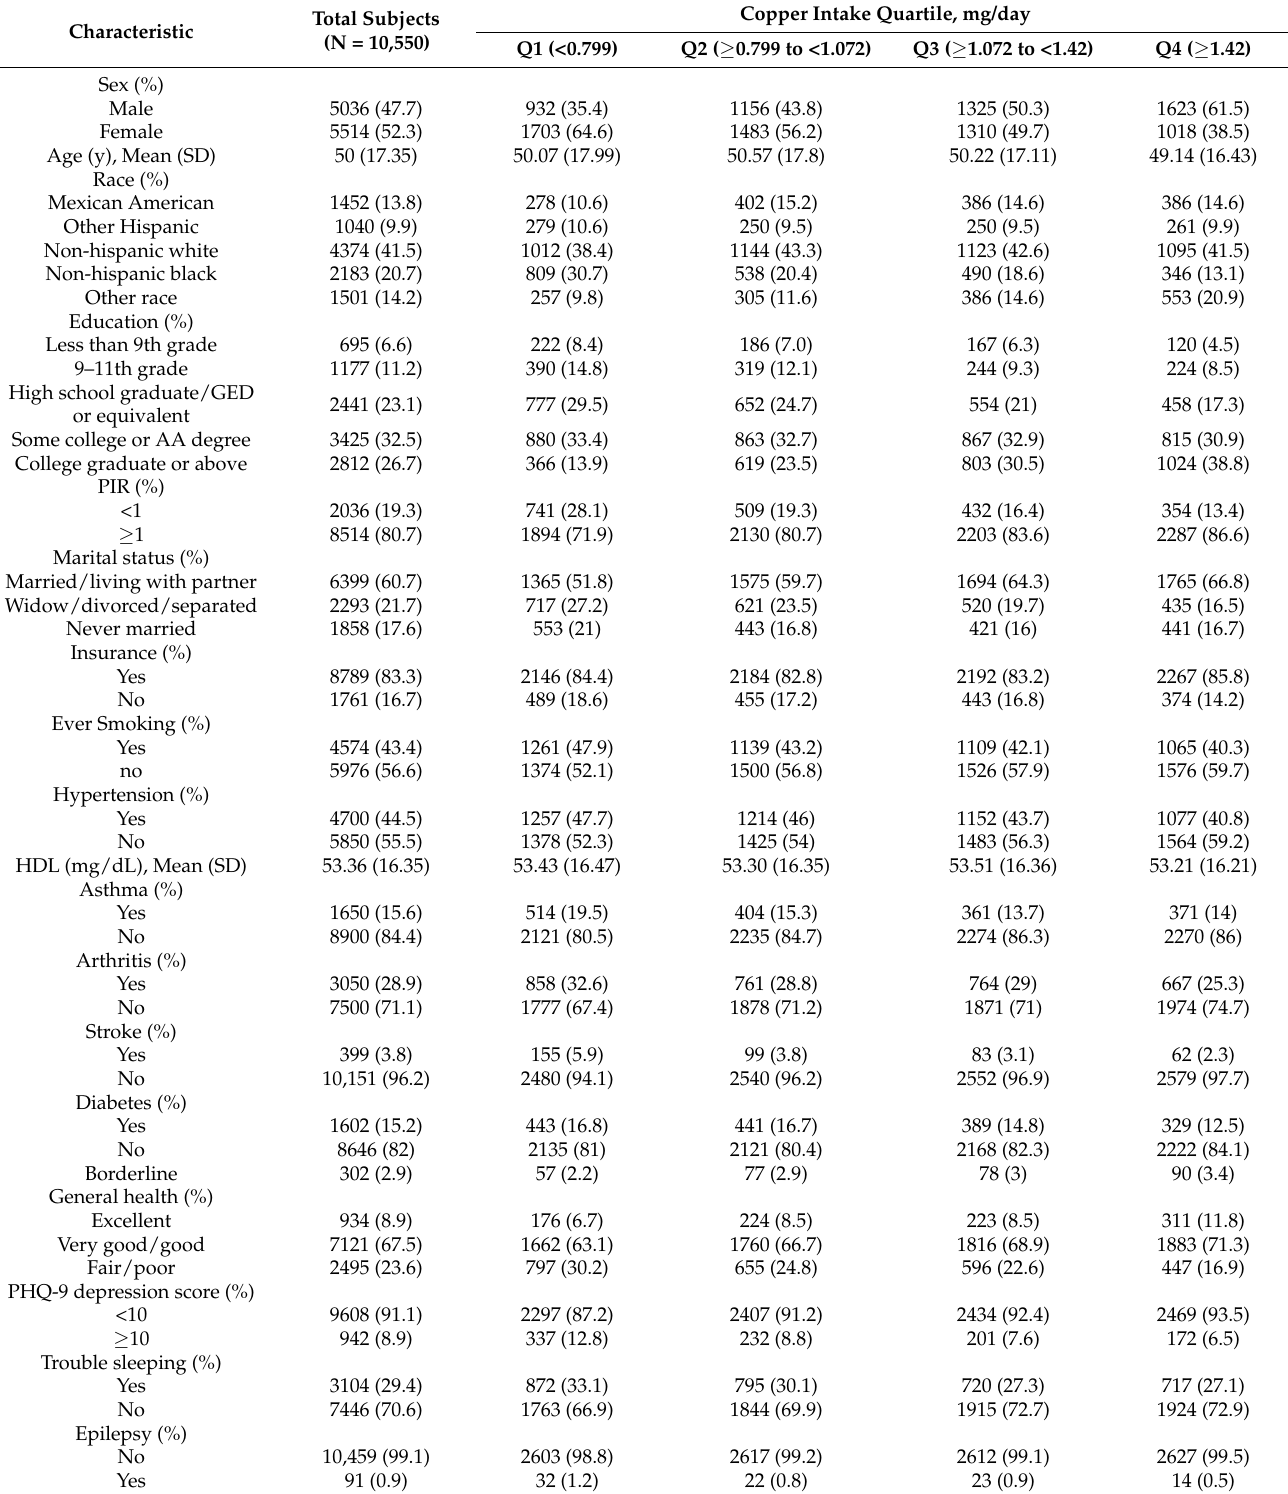
Table 1. Baseline characteristics for the total subjects, as well as stratified by quartile of copper